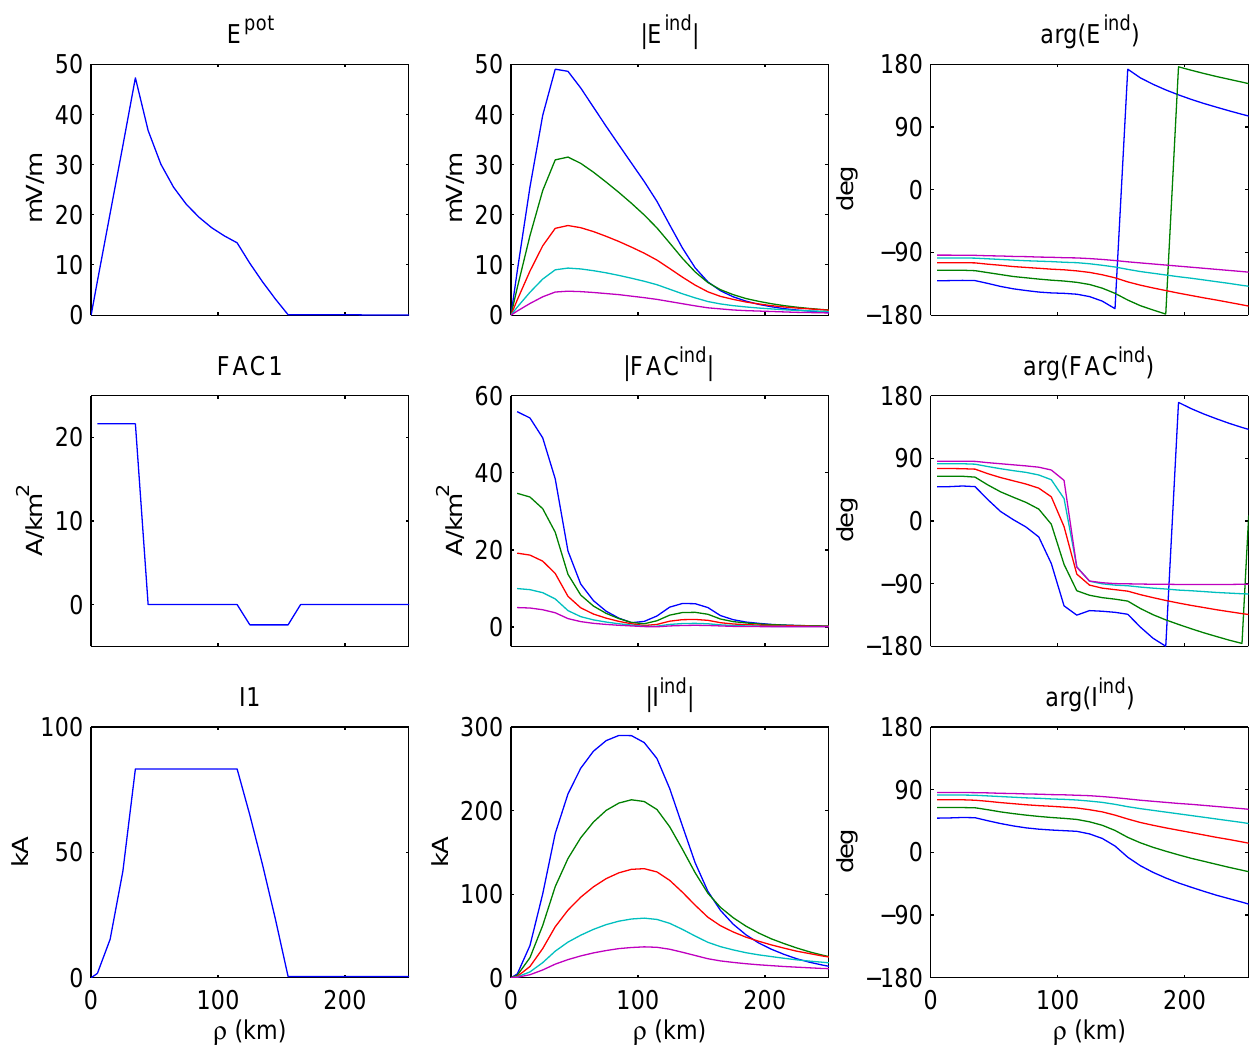
Fig. 2. Input system (electric field E pot , field-aligned current density FAC1 and the total field-aligned current I1) is rotationally symmetric and oscillates harmonically in time. Upper row: Input electric field, and magnitude and phase of the induced electric field E ind . Middle row: Same for the FAC. Bottom row: same for the integrated FAC inside radius ρ . In these examples conductances are uniform, 6 P = 8S and 6 H = 16S. Oscillation time T is varied: T =1, T =2, T =4, T =8 and T